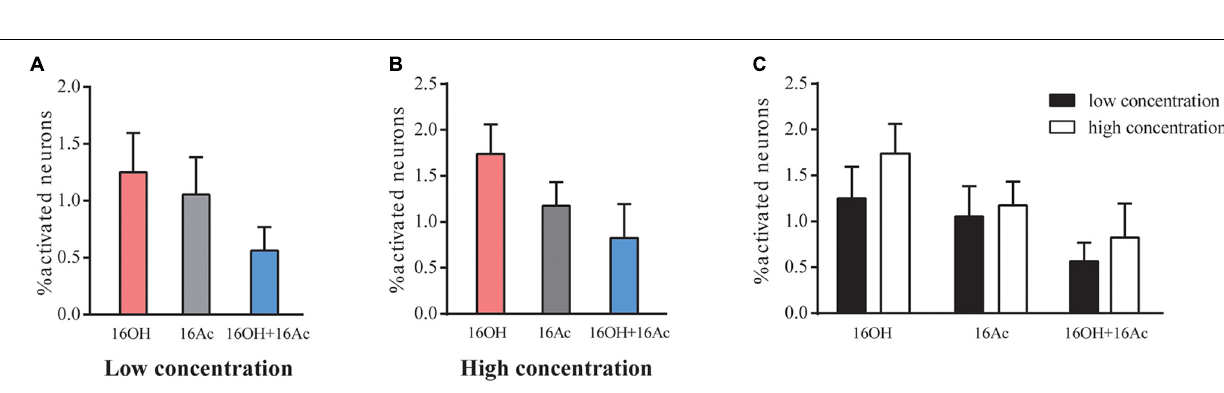
Frontiers in Cellular Neuroscience |